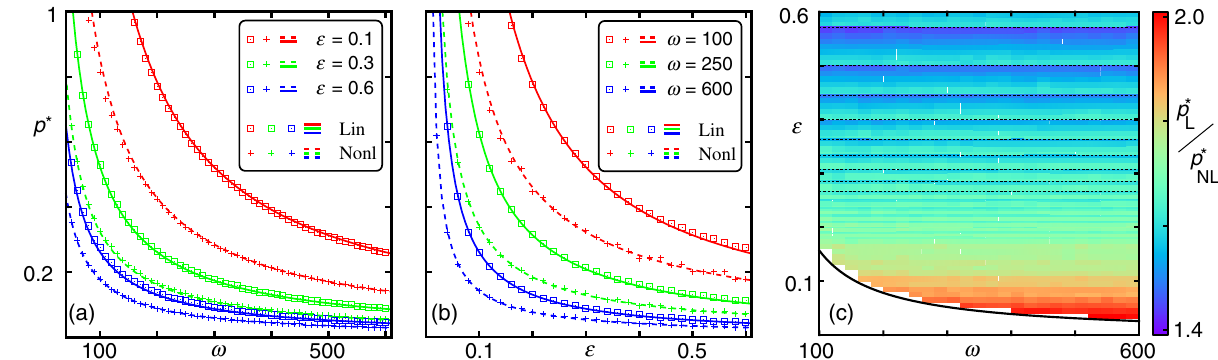
FIG. 3. Critical connectivity in isolated FFNs. (a),(b) Network simulations (symbols) agree well with analytical predictions (solid lines) (30) and (45). The critical connectivity decays with layer size and coupling strength. (c) The reduction factor c ¼ p (cid:8) L =p (cid:8) NL > 1 shows that nonlinear dendritic interaction compensates for reduced connectivity. In both scenarios, with linear and nonlinear coupling, we find that p (cid:8) / ! (cid:1) 1 , such that the reduction factor is independent of the layer size. In networks with linear couplings, the critical connectivity is p (cid:8) / (cid:4) (cid:1) 1 , whereas, in networks with nonlinear coupling, the dependence on (cid:4) (cid:1) 1 is nonlinear. Therefore, the reduction factor increases with decreasing coupling strength. Dashed horizontal lines indicate jumps in the reduction factor at which the number of inputs needed for dendritic spike generation